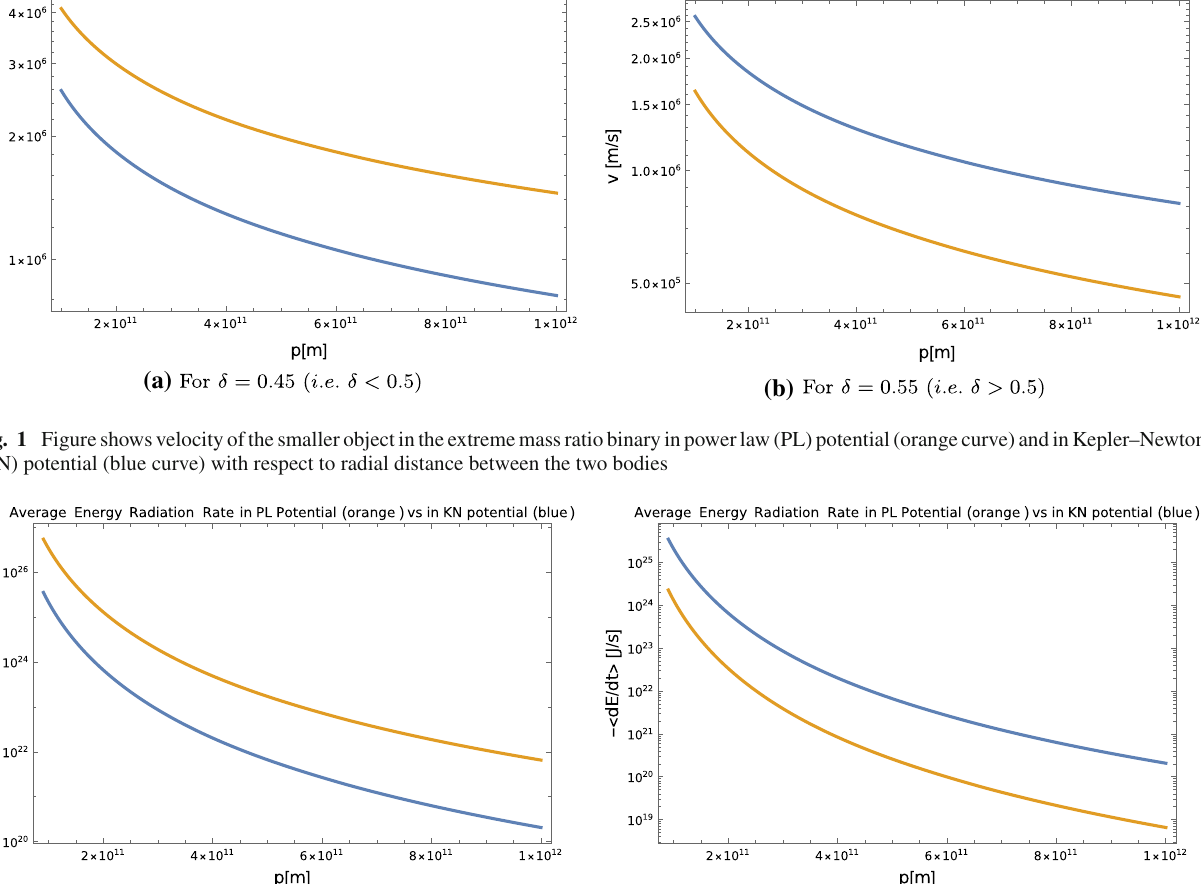
respect to radial distance ( p ) between the two bodies. Note that the y axis denotes the negative of average of rate of change of energy. Which means that the system is losing energy